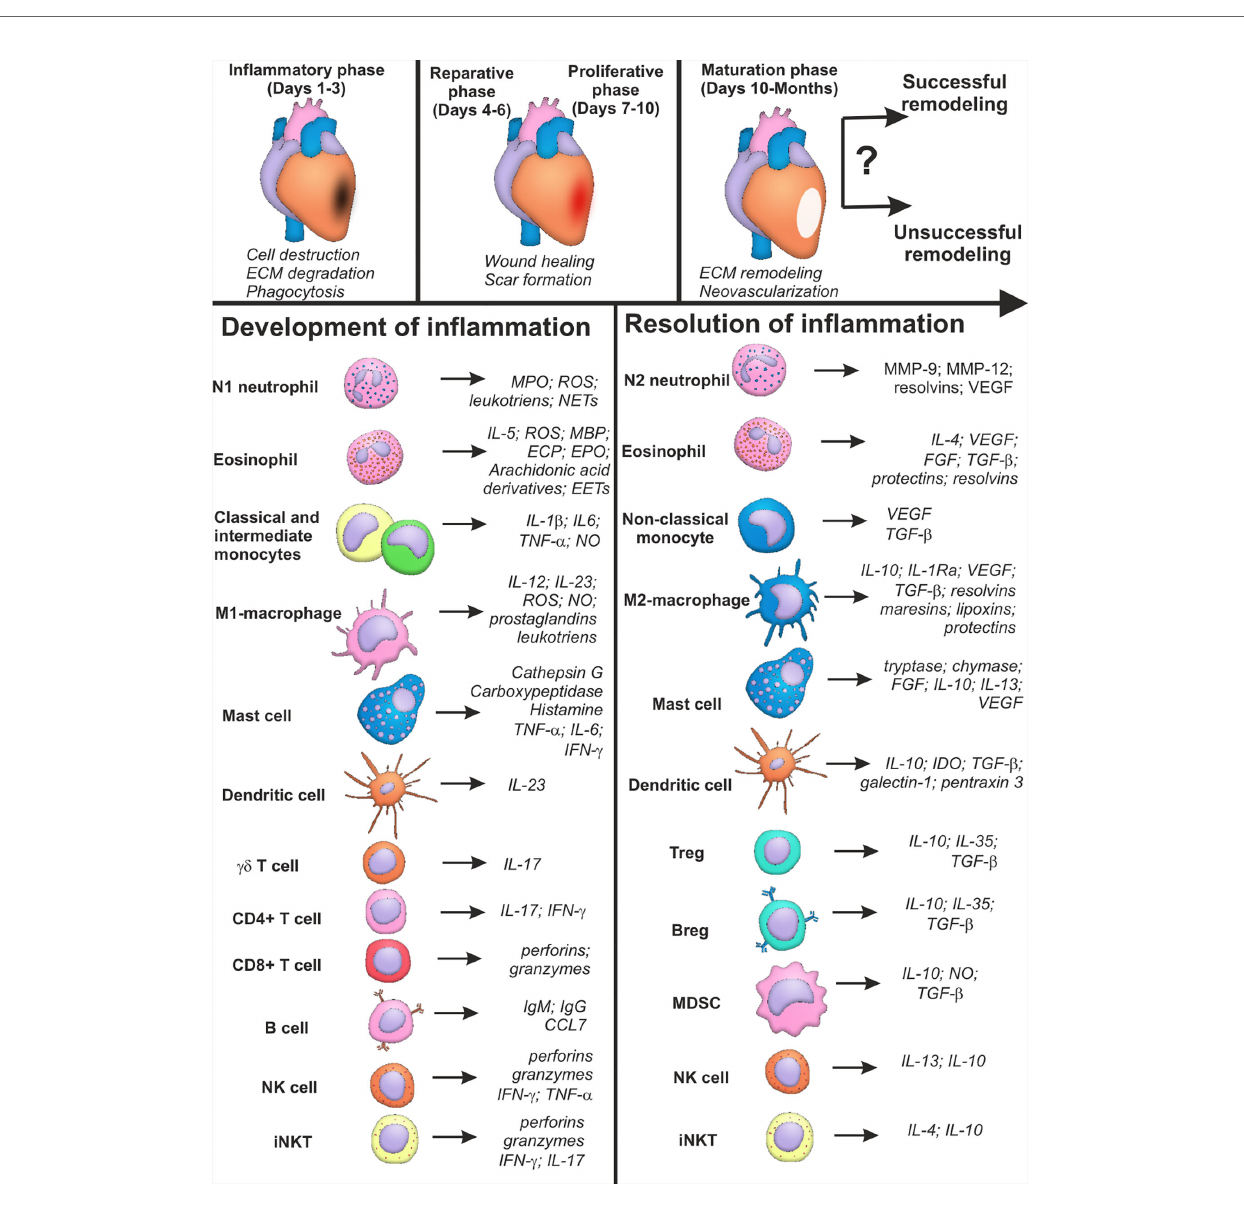
FIGURE 1 | Summary characteristics of immune cells involved in development and resolution of in fl ammation post-myocardial infarction. Cells of the immune system may input either successful or unsuccessful myocardial remodeling after myocardial infarction, being involved in all the three phases of cardiac repair: in fl ammatory phase; reparative and proliferative phase; maturation phase. Some cellular populations (monocytes, macrophages, lymphocytes) are represented by two or more subsets with opposite or complementary effects. At the same time, some immune cells may exhibit either in fl ammatory or reparative properties, depending on the nature of the signal and cellular milieu (eosinophils, dendritic cells, mast cells, NK cells, iNKT cells). Possibility exists that new distinct subpopulations of immune cells are yet to be described, and in fl ammatory and reparative functions will further be ascribed to different cellular subsets. CCL CC, Chemokine ligand; CD, Cluster of differentiation; ECP, Eosinophil cationic protein; FGF, Fibroblast growth factor; IFN, Interferon; Ig, Immunoglobulin; IL, Interleukin; IL-1Ra, Interleukin-1 receptor antagonist; MBP, Major basic protein; MMP, Matrix metalloproteinase; MPO, Myeloperoxidase; NO, Nitric oxide; ROS, Reactive oxygen species; TGF, Transforming growth factor; TNF, Tumor necrosis factor; VEGF, Vascular endothelial growth factor; Question marks indicate absent or incomplete data and facts that have not been suf fi ciently studied for myocardial